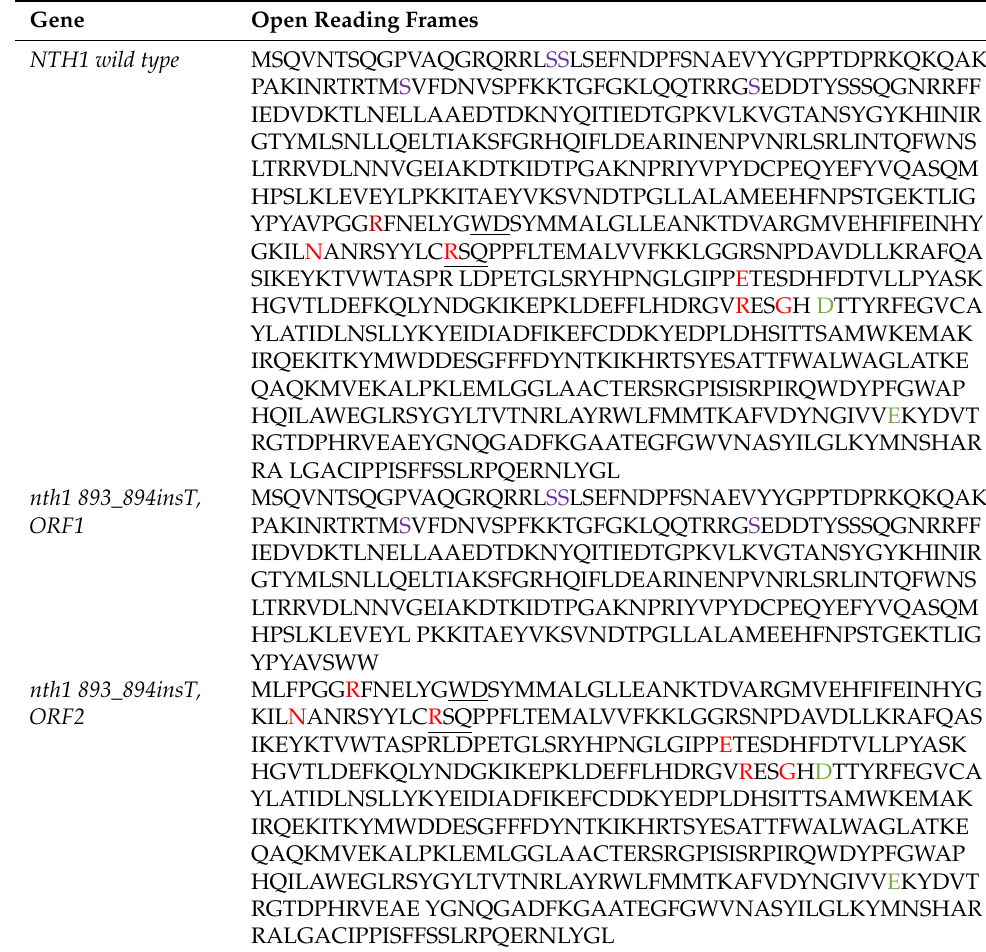
Table 1. Predicted Open Reading Frames (ORF) of mutants in comparison with the wild-type NTH1 and NTH2 genes. Gene Open Reading Frames NTH1